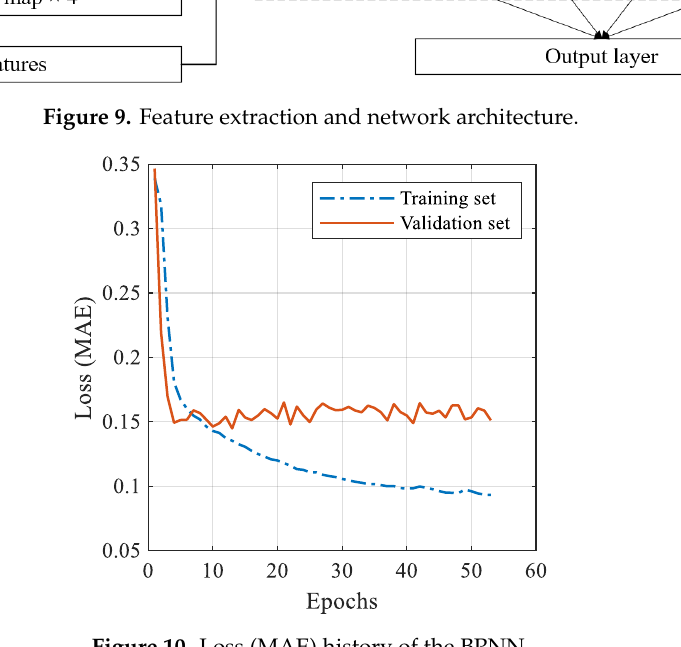
Figure 10. Loss (MAE) history of the BPNN.